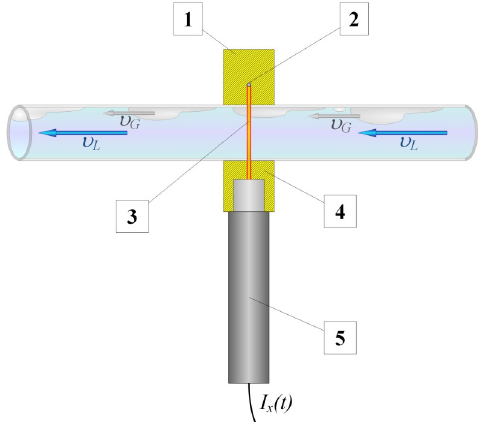
Fig. 1. The principle of gamma-absorption method: 1 – collimator, 2 - gamma radioactive source, 3 – gamma ray, 4 – collimator of detector, 5 - scintillation detector, υ G – velocity of gas, υ L – velocity of liquid